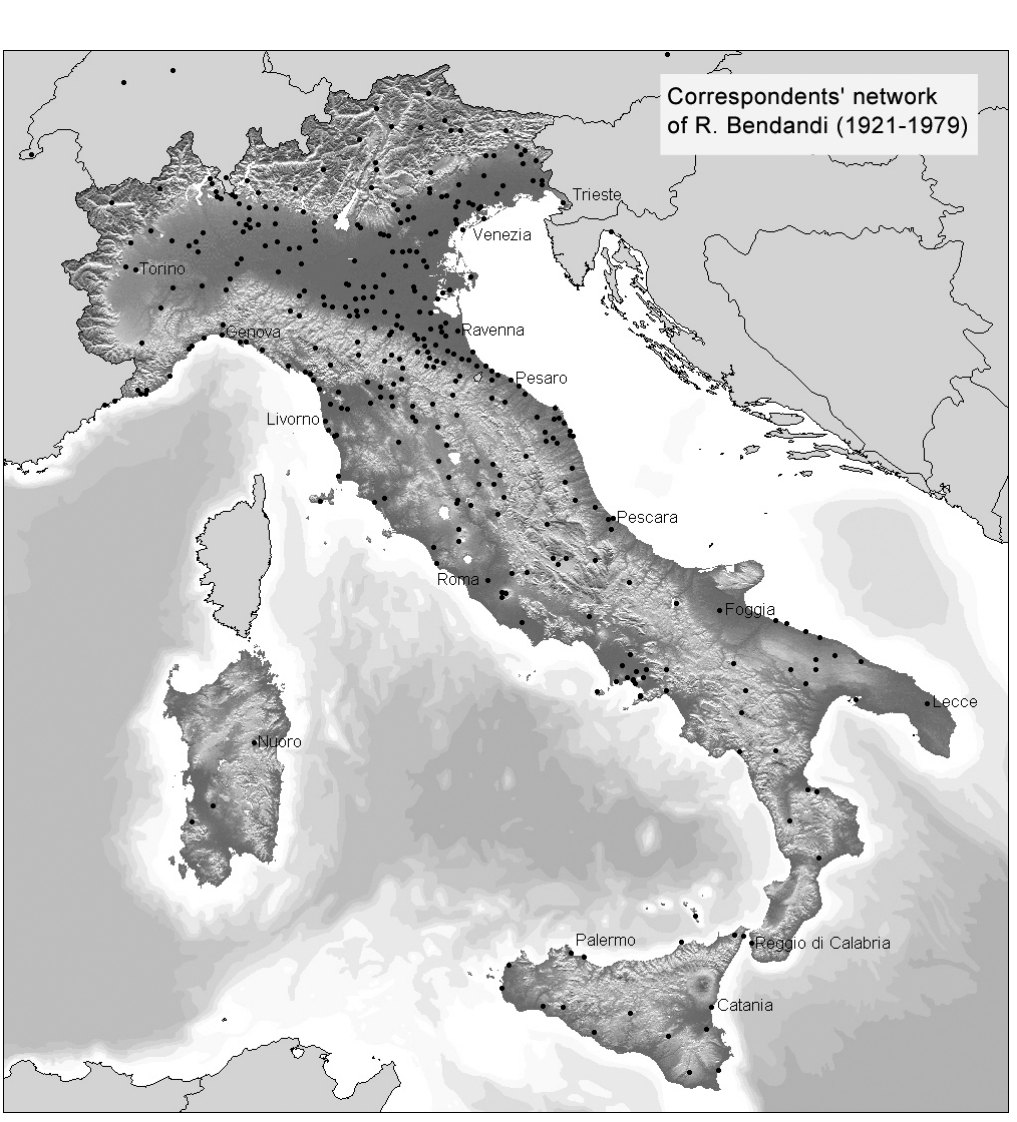
Fig. 3. Geographical localisation of the senders in Italy of letters to